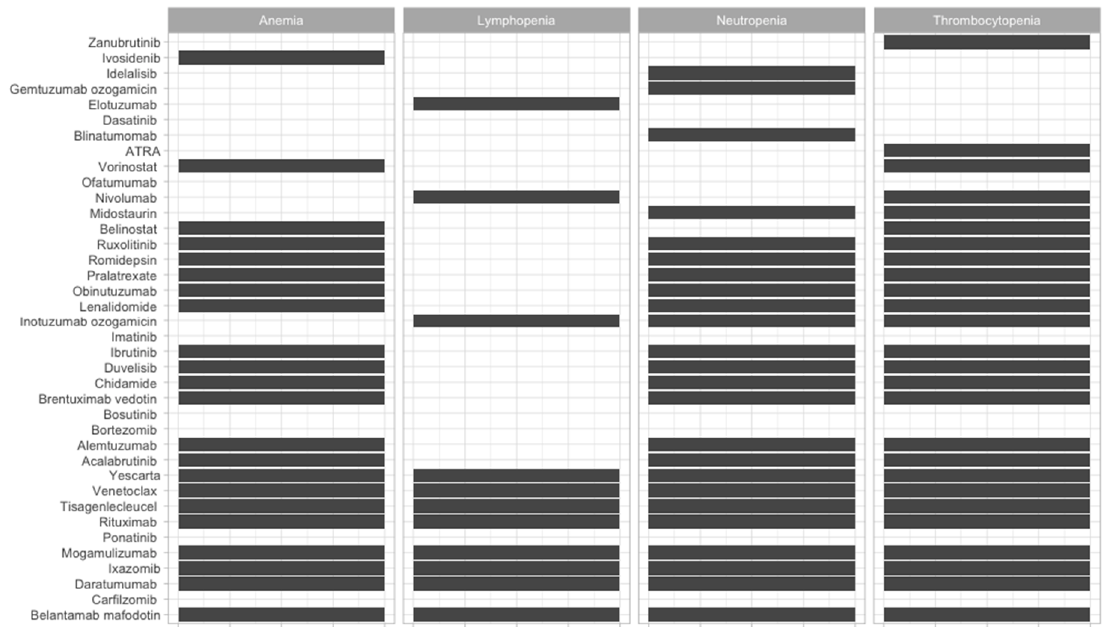
Figure 6. Hematologic side-e ff ects of FDA-approved and non-approved drugs for hematological disorders.